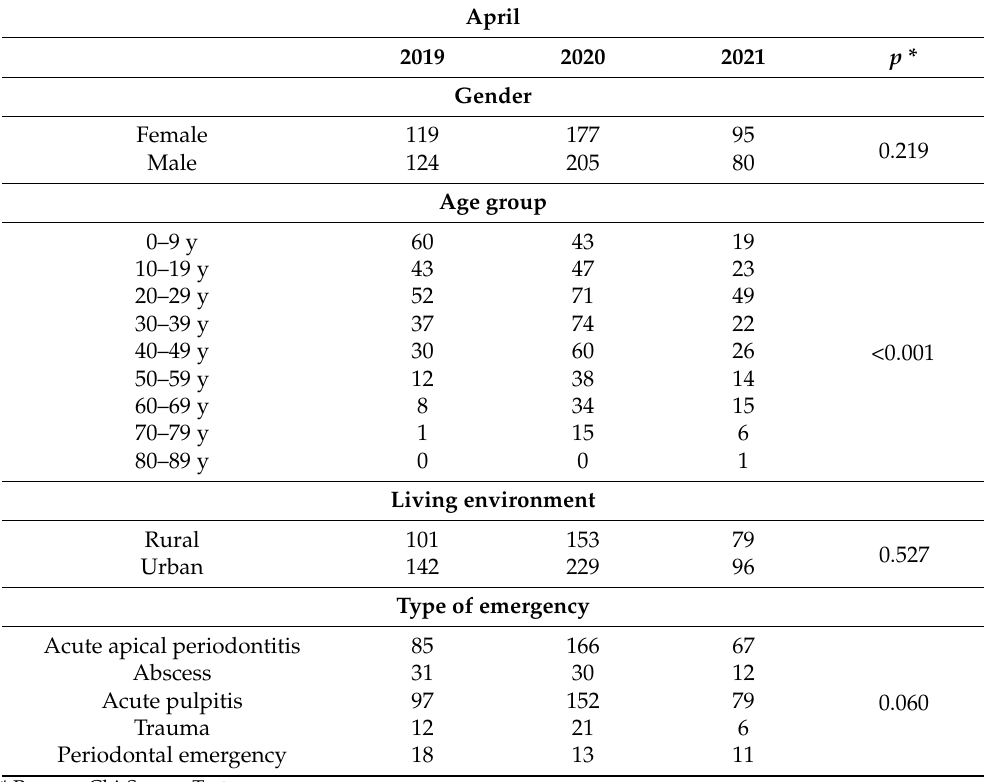
Table 4. Evolution for April 2019, 2020, and 2021 according to the investigated